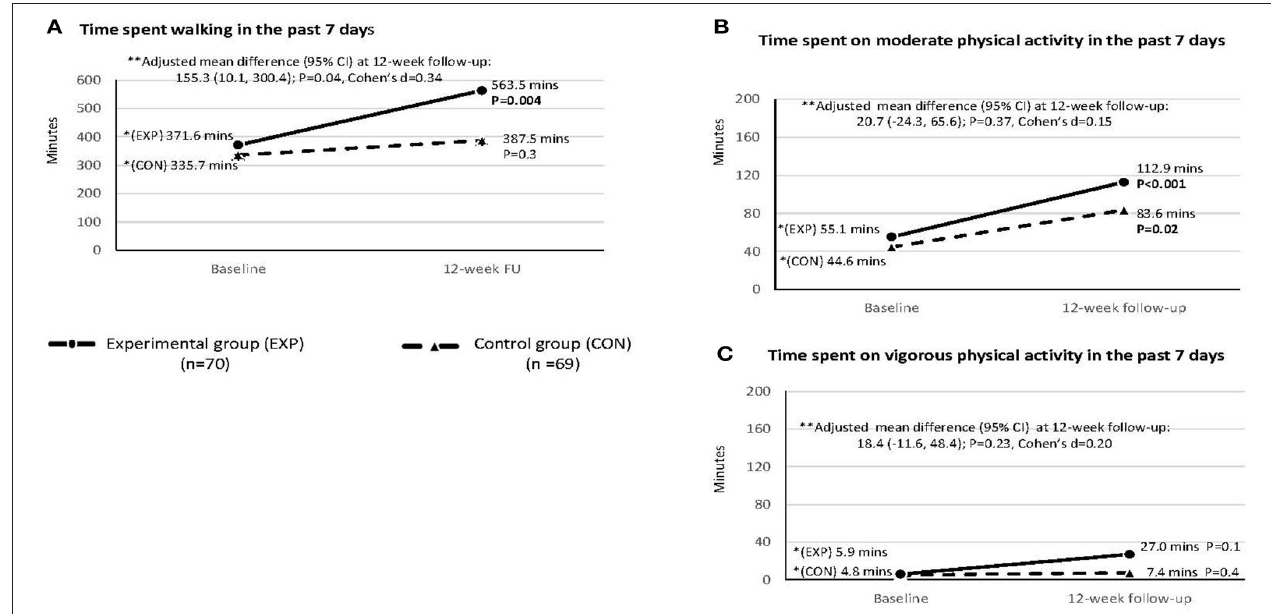
FIGURE 2 | Time spent walking and moderate and vigorous physical activities in the 7 days at baseline and 12-week follow-up: Intention to treat analysis ( n = 139). This was measured by the short form of International Physical Activity Questionnaire—Chinese version. *Within-group comparison was done by paired sample t-test. **Between-group comparison by linear mixed model with adjustment of age, sex and baseline values; Cohen’d effect size ∼ 0.2, medium effect ∼ 0.5, and large effect ∼ 0.8 or above.